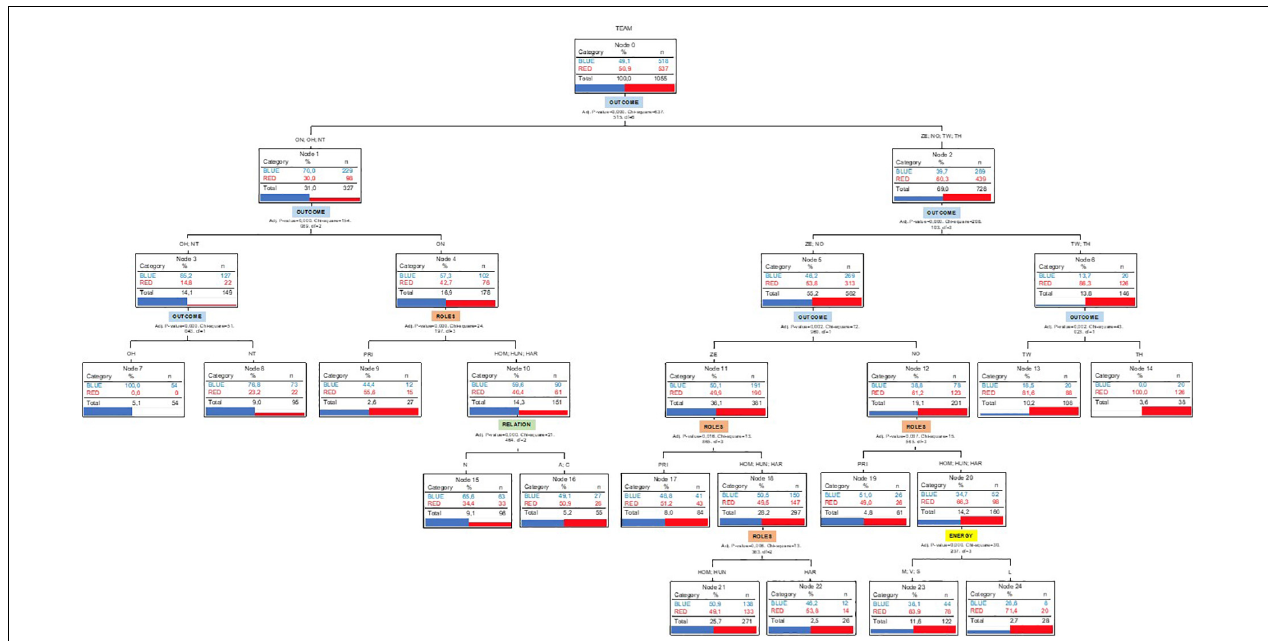
FIGURE 4 | Classification tree (QUEST) to identify the predictive capacity of different variables that explain the Strategic Conduct of the Blue and Red Teams.